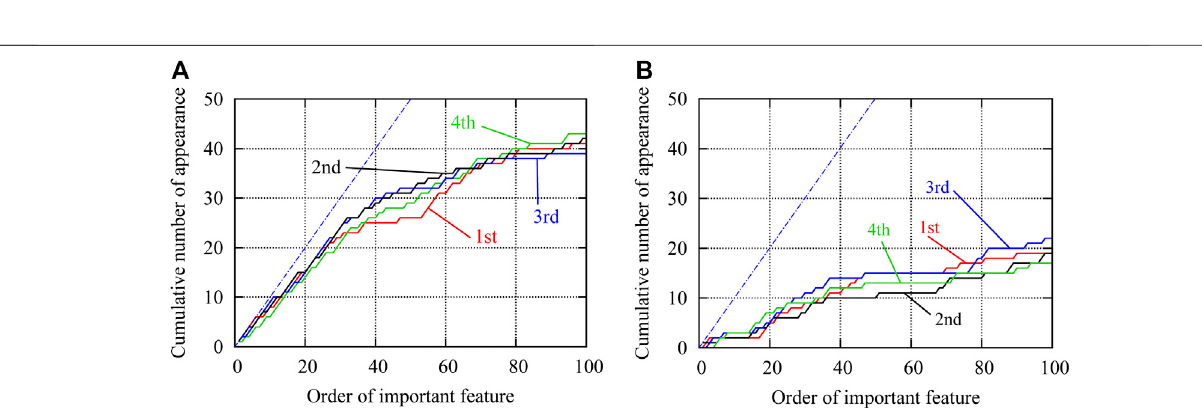
Frontiers in Built Environment |